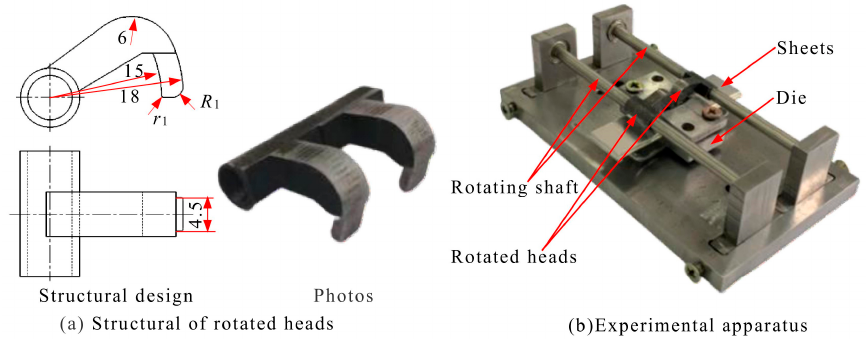
Figure 11. Structure of rotated head and experimental apparatus for rotated clinching forming.